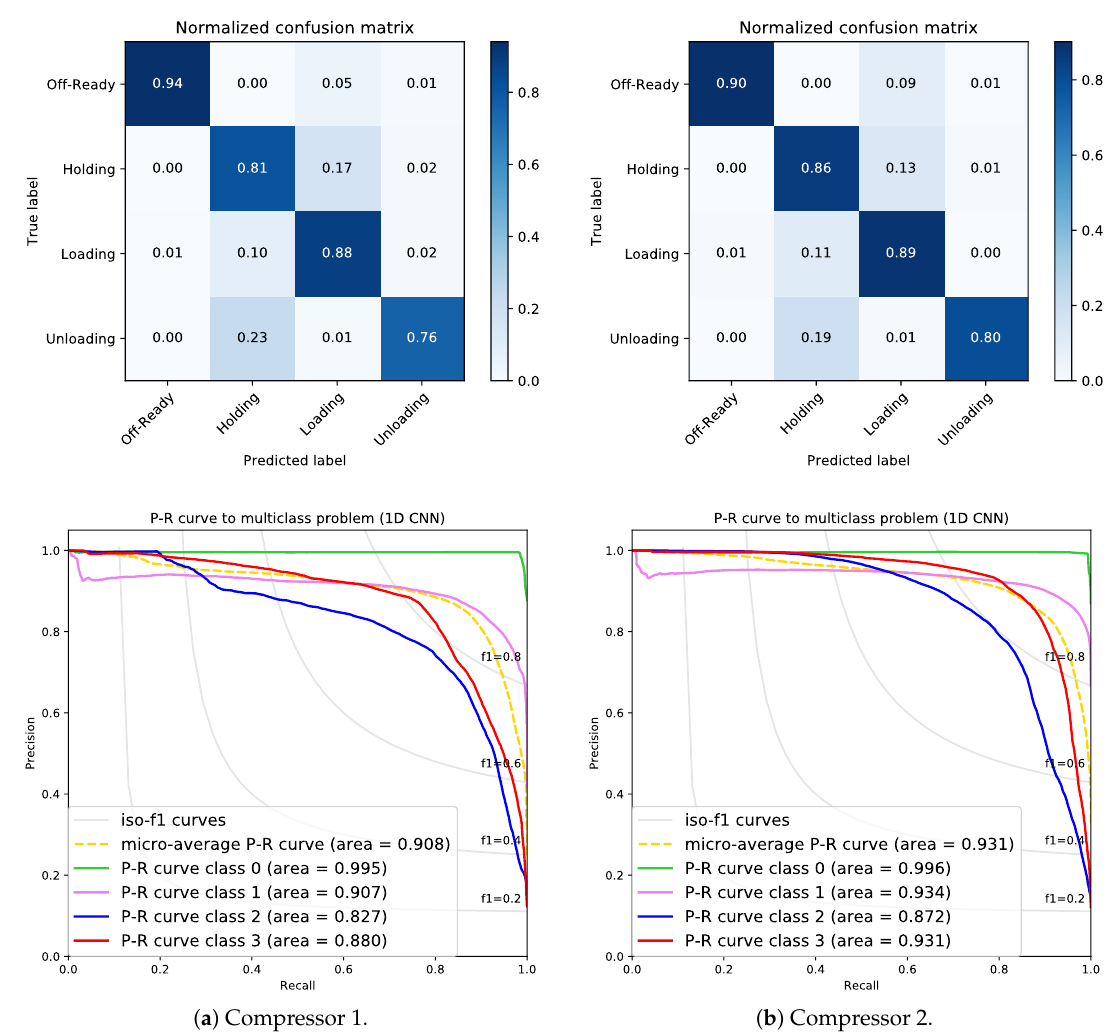
Figure 8. Confusion matrices and PR curves using sensor data from similar compressors 1 and